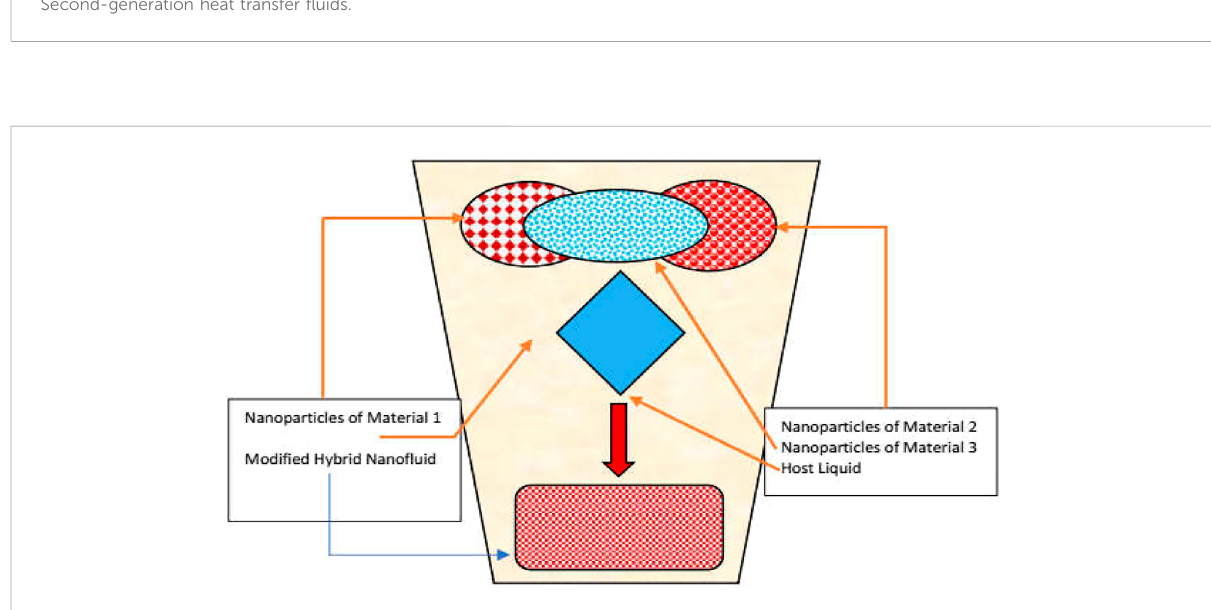
FIGURE 3 Third-generation heat transfer fl uids.